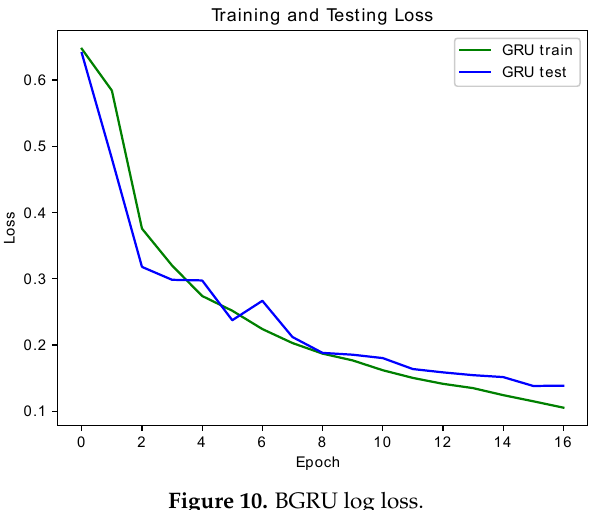
Figure 10. BGRU log